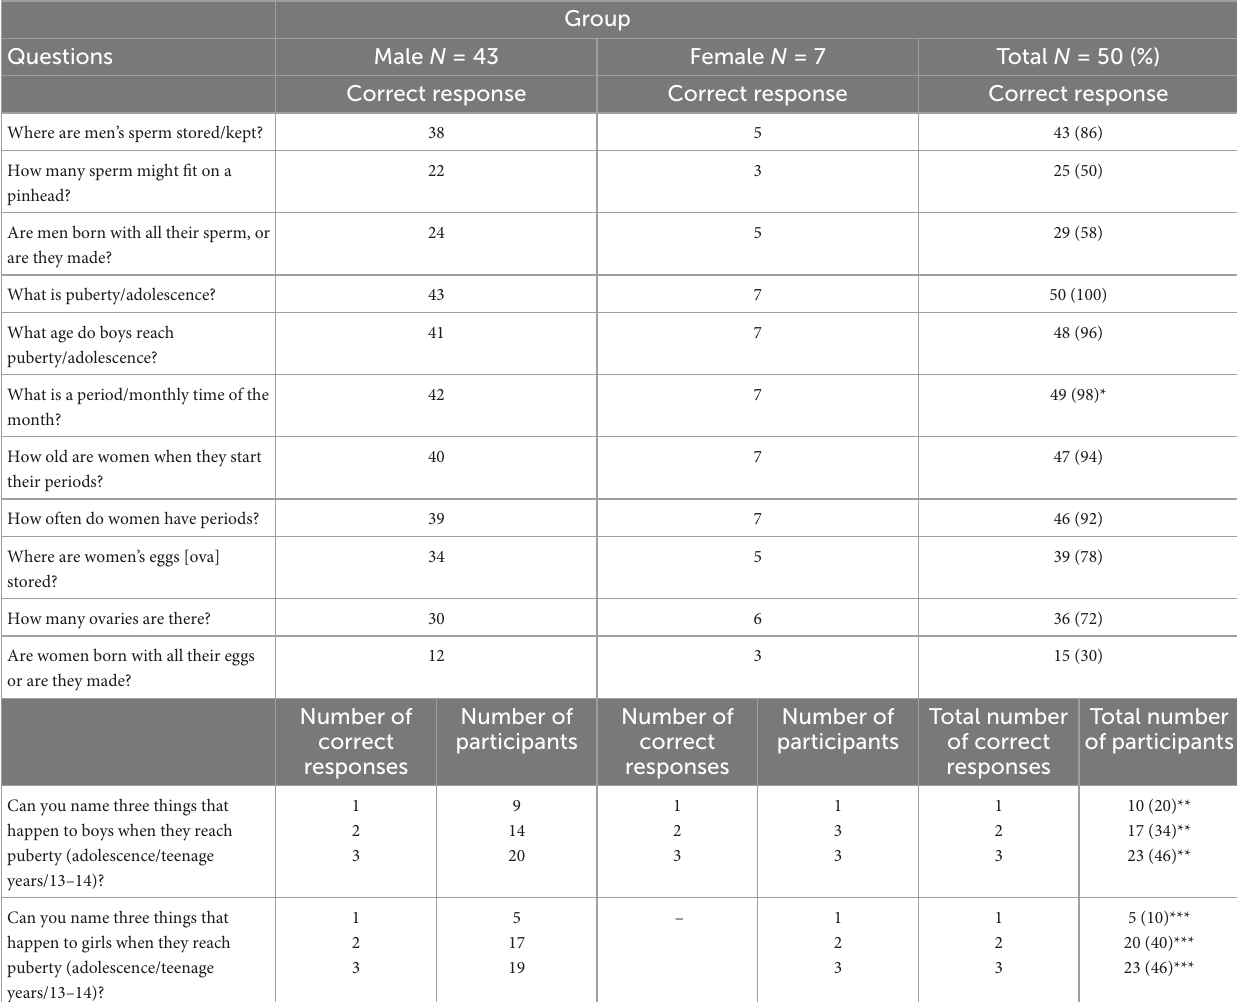
TABLE 5 Physiology